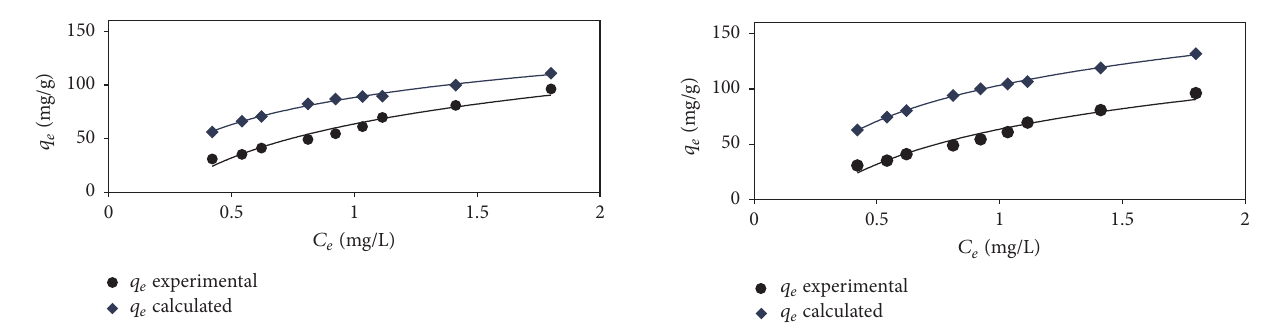
Figure 13: Extended Langmuir model for RB-5 in binary system with RR-RB (temp. = 25 ∘ C, speed = 200 rpm, time = 24 hr., and con. of RR-RB = con. of RB-5 = 100mg/L).